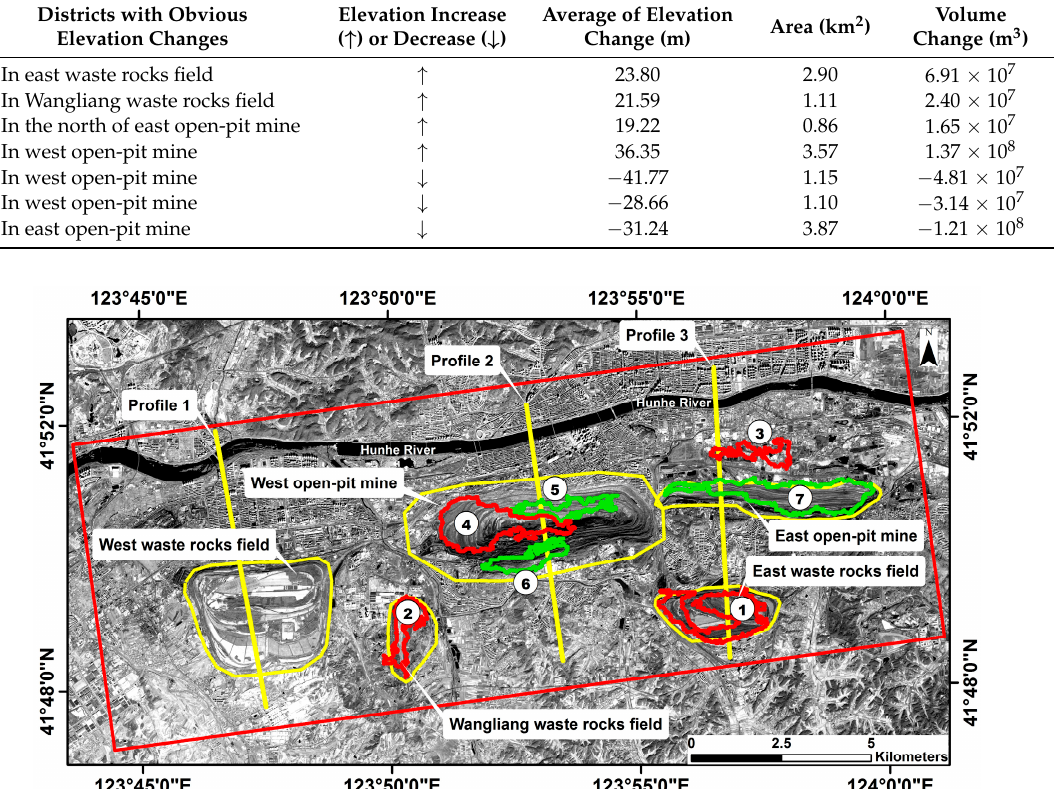
Figure 7. Distribution of the seven districts with obvious elevations increase (red polygons) and elevations decrease (green polygons).